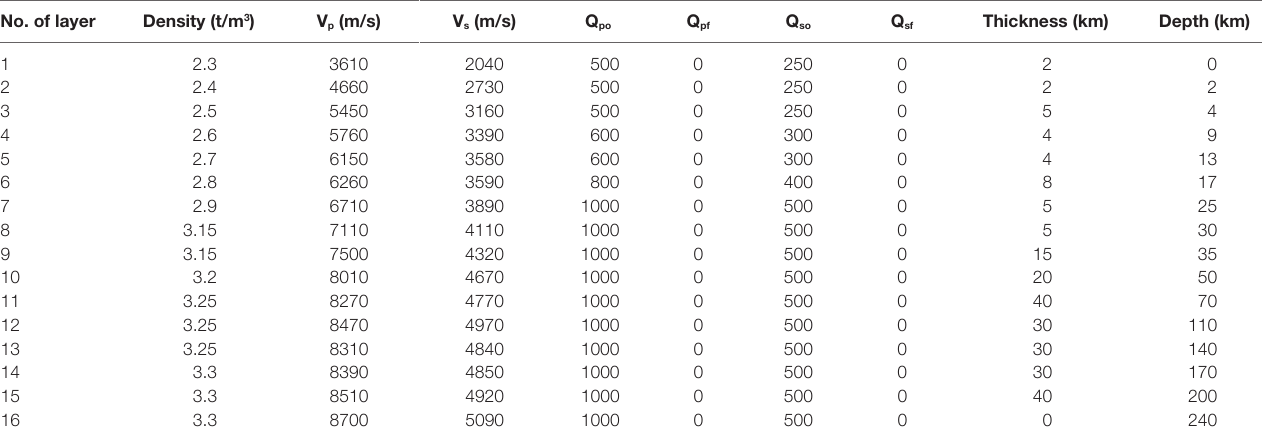
TaBle 1 | soil layered condition of chi-chi earthquake for hanging